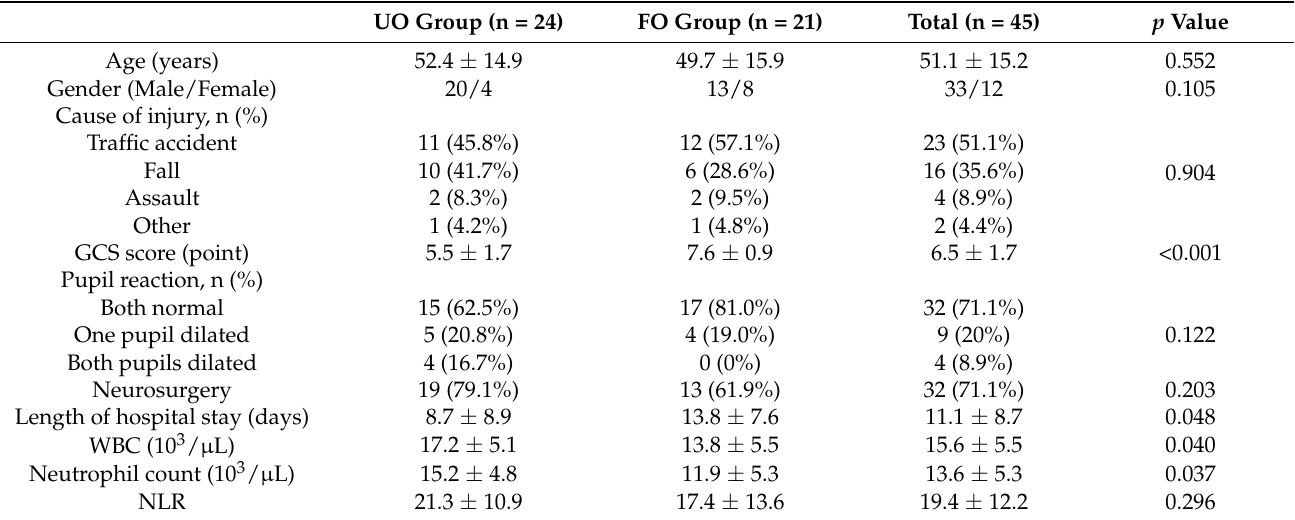
Table 1. Demographic and clinical characteristics of the severe TBI patients grouped by GOS score at